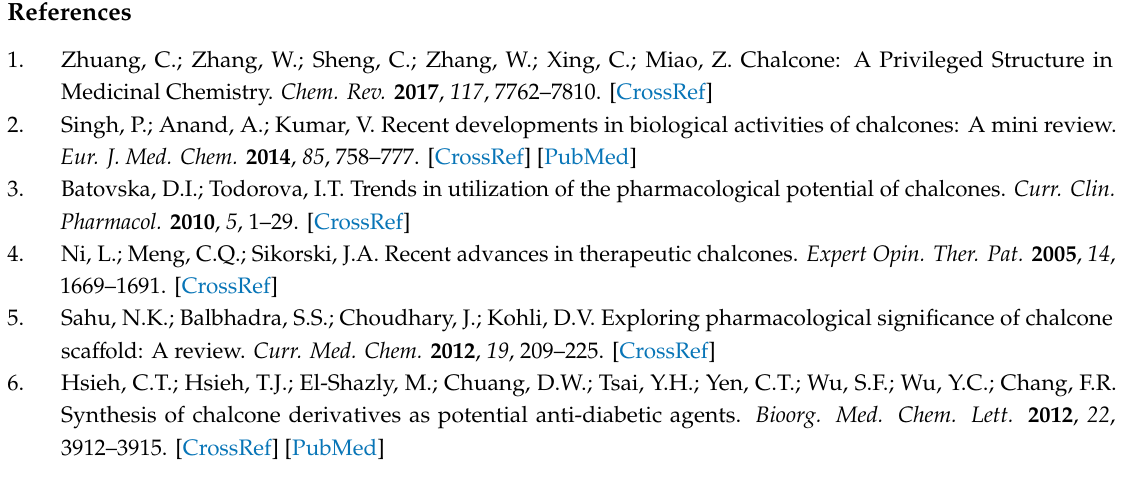
Supplementary Materials: The following are available online, Figure S1: AN07 itself does not a ff ect the neurite outgrowth of SH-SY5Y